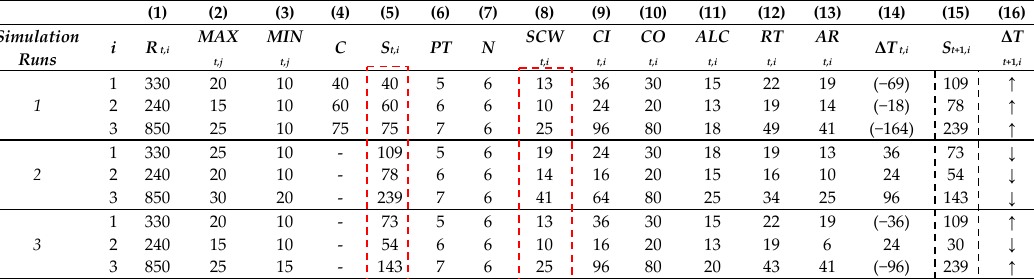
Table 2. The dynamic adjusting model in the Monte Carlo simulation.